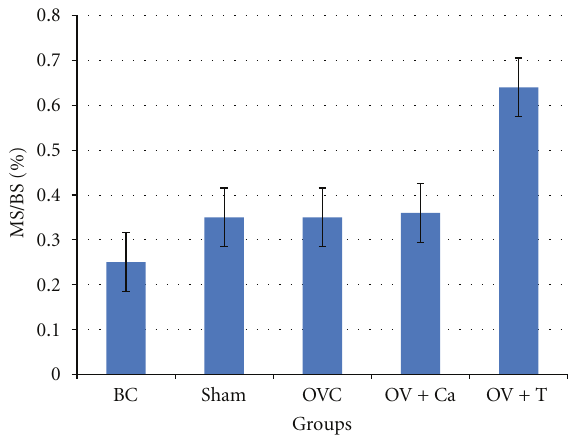
Figure 3: Mineralising surface (MS/BS). BC: baseline control group. Sham: sham-operated rats given deionised water and vehicle olive oil. OVC: ovariectomised rats given deionised water and vehicle olive oil. Ov+Ca: ovariectomised rats given 1% calcium in deionised water and vehicle olive oil. Ov+T: ovariectomised rats given deionised water and palm tocotrienol. No significant di ff erence was seen between the groups at P < 0 . 05.